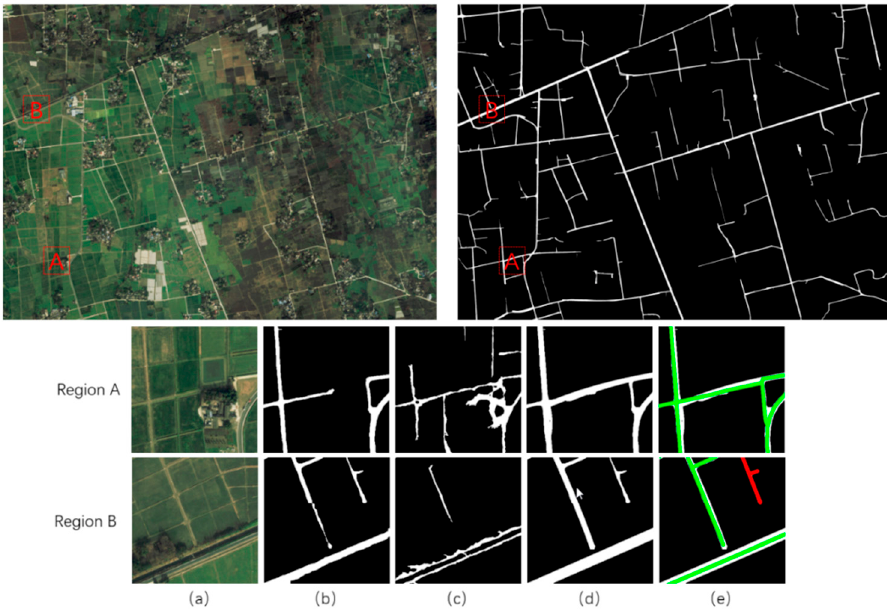
Figure 23. Tested data Area 1. Some details in optical and SAR remote sensing images and road extraction results in the Chongzhou area. ( a ) Worldview-4 optical remote sensing image; ( b ) road extraction results of optical remote sensing image; ( c ) road extraction results from the SAR remote sensing images; ( d ) road fusion extraction results of optical and SAR images; ( e ) ground truth and marking results of road fusion extraction results (green refers to the correctly extracted road, red refers to the incorrectly extracted road, and yellow refers to the omitted real road).